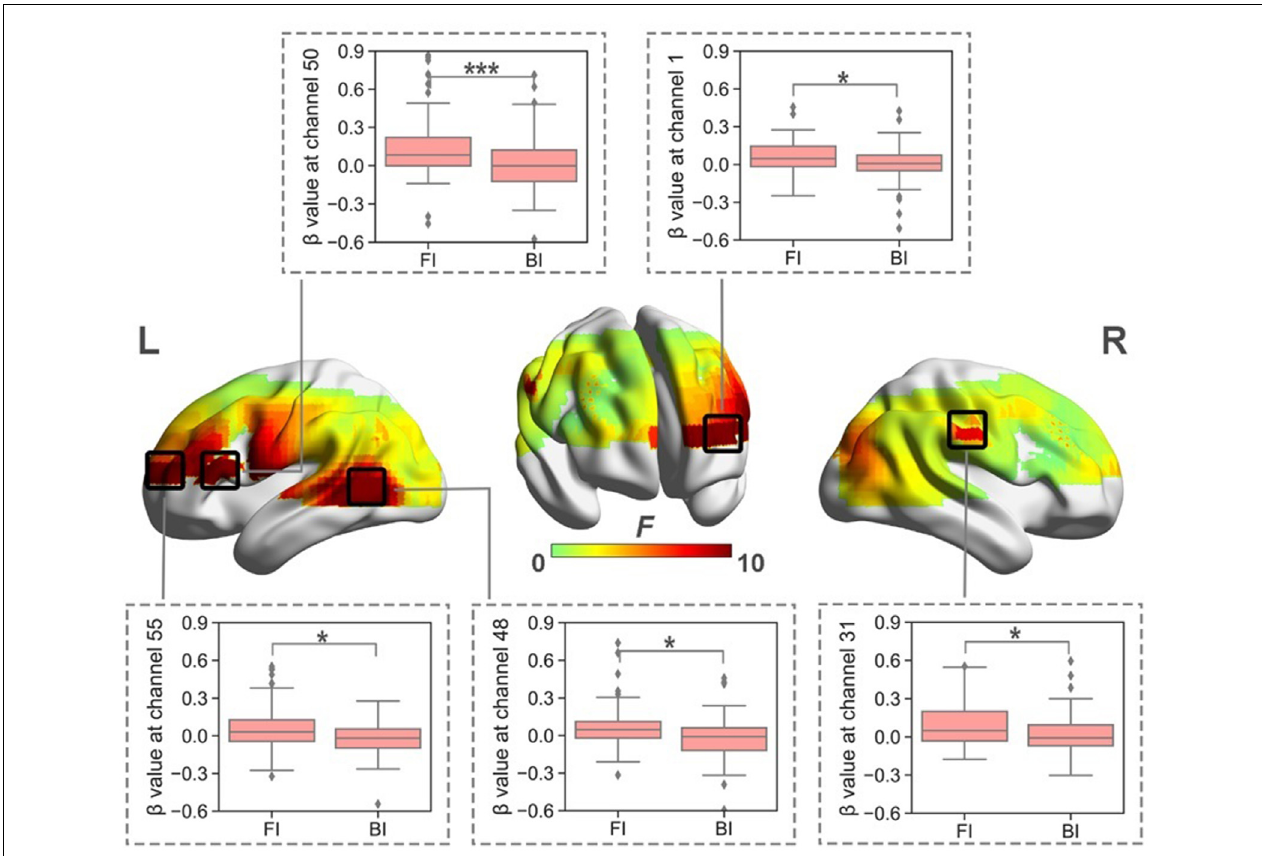
FIGURE 4 | The heat map corresponding to the activated channels impacted by the main effect of interpreting direction in HbO, when normalized for reading; the average β value for such main effect in the activated channels. * p < 0.05; *** p < 0.001. Error bars represent minimum/maximum values. The diamond dots mean extreme values. The shaded area indicates the 95% confidence